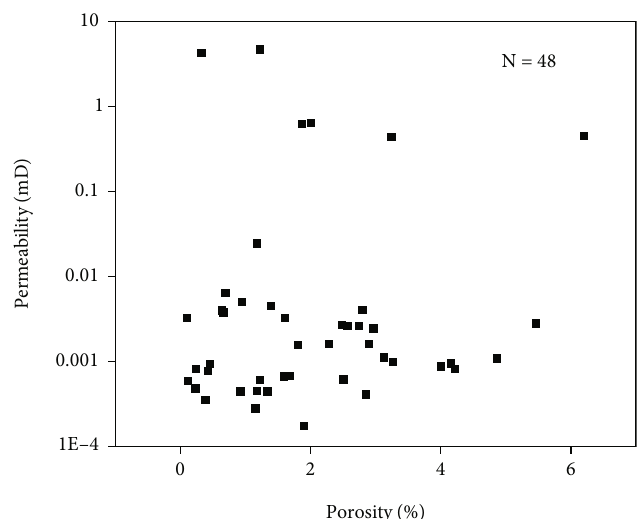
Figure 11: Porosity-permeability cross-plot.